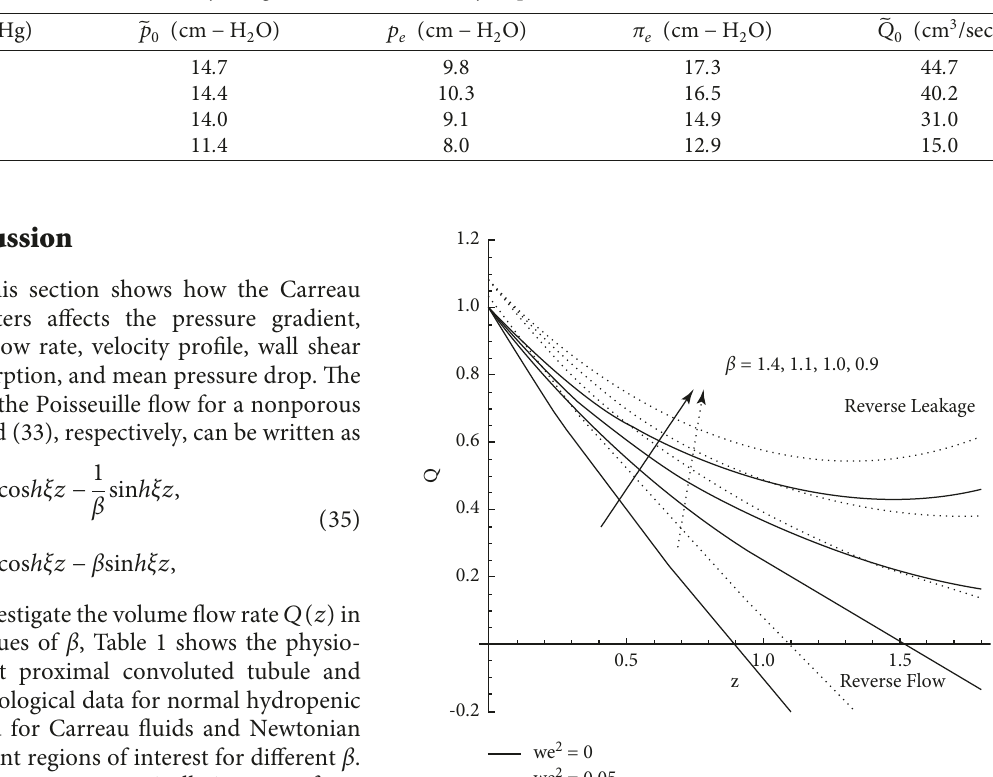
Table 2: Physiological data for normal hydropenic rats [6, 8].